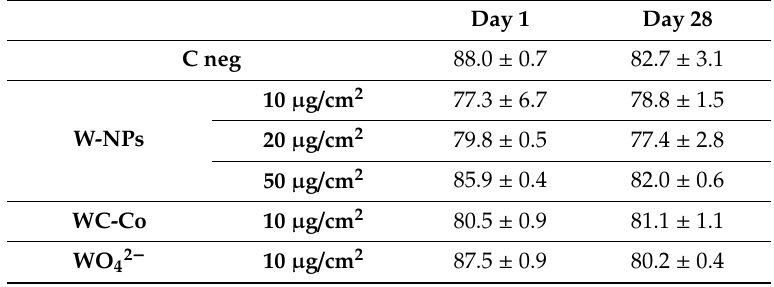
Table 1. Comparison of the viability of MucilAir ™ cells at di ff erent time points.